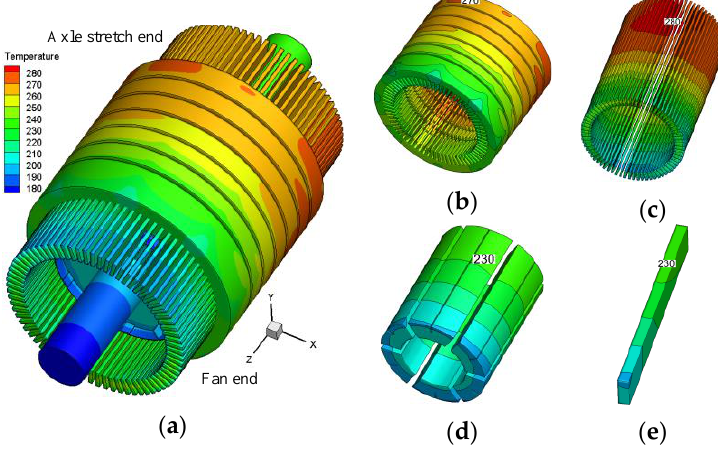
Figure 8. Temperature distribution of each component in the motor with single ventilation path air-cooled system: ( a ) motor; ( b ) Stator core; ( c ) Stator winding; ( d ) Rotor core; ( e ) Permanent magnet.